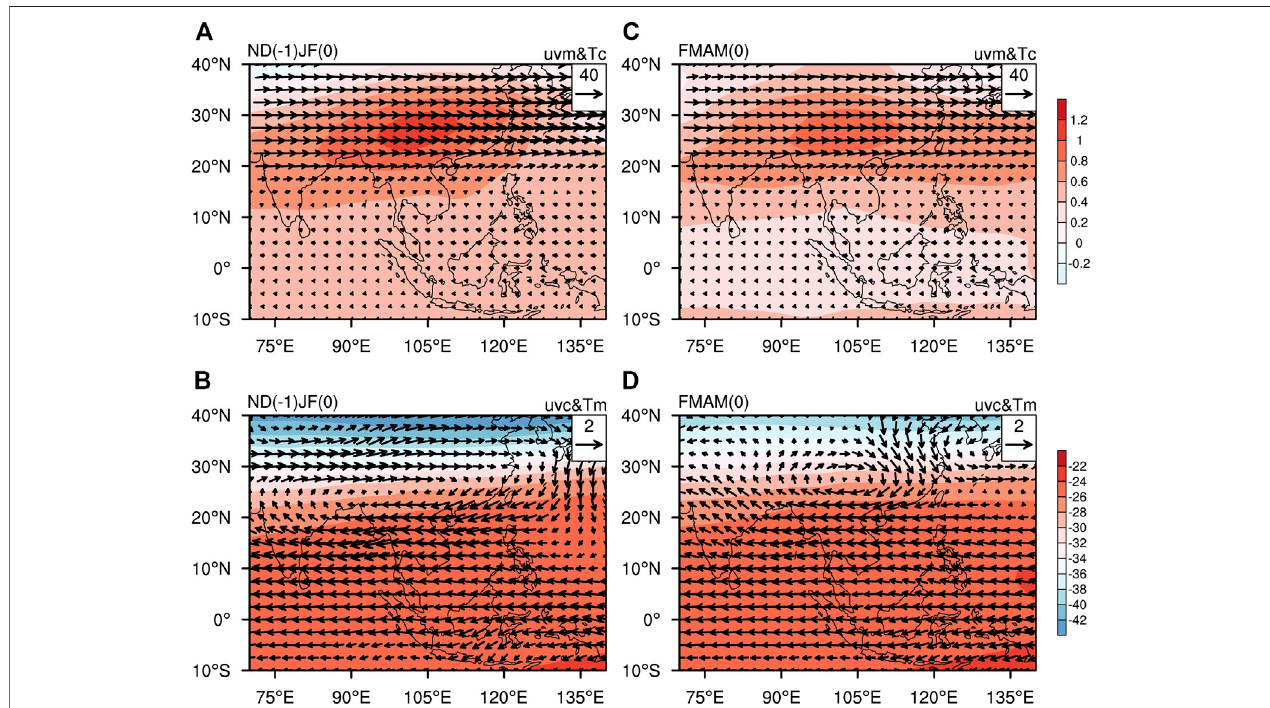
FIGURE 8 | (A) Climatologically mean 500 – 200 hPa wind (arrows, m/s) and the epochal differences of the 500 – 200 hPa temperature (color shading, K) in November – February. (B) Climatologically mean 500 – 200 hPa temperature (color shading, K) and the epochal differences of 500 – 200 hPa wind (arrow, m/s) in November – February. (C) Same as (A) , but for February – May. (D) Same as (B) , but for February – May. Climate-mean state: “ ( − 1) ” and " (0)" denote the mean state of 1979 – 2016 and 1980 – 2017, respectively. For the epochal difference, “ ( − 1) ” and “ (0) ” denote (1993 – 2016) minus (1979 – 1992), and (1994 – 2017) minus (1980 – 1993),